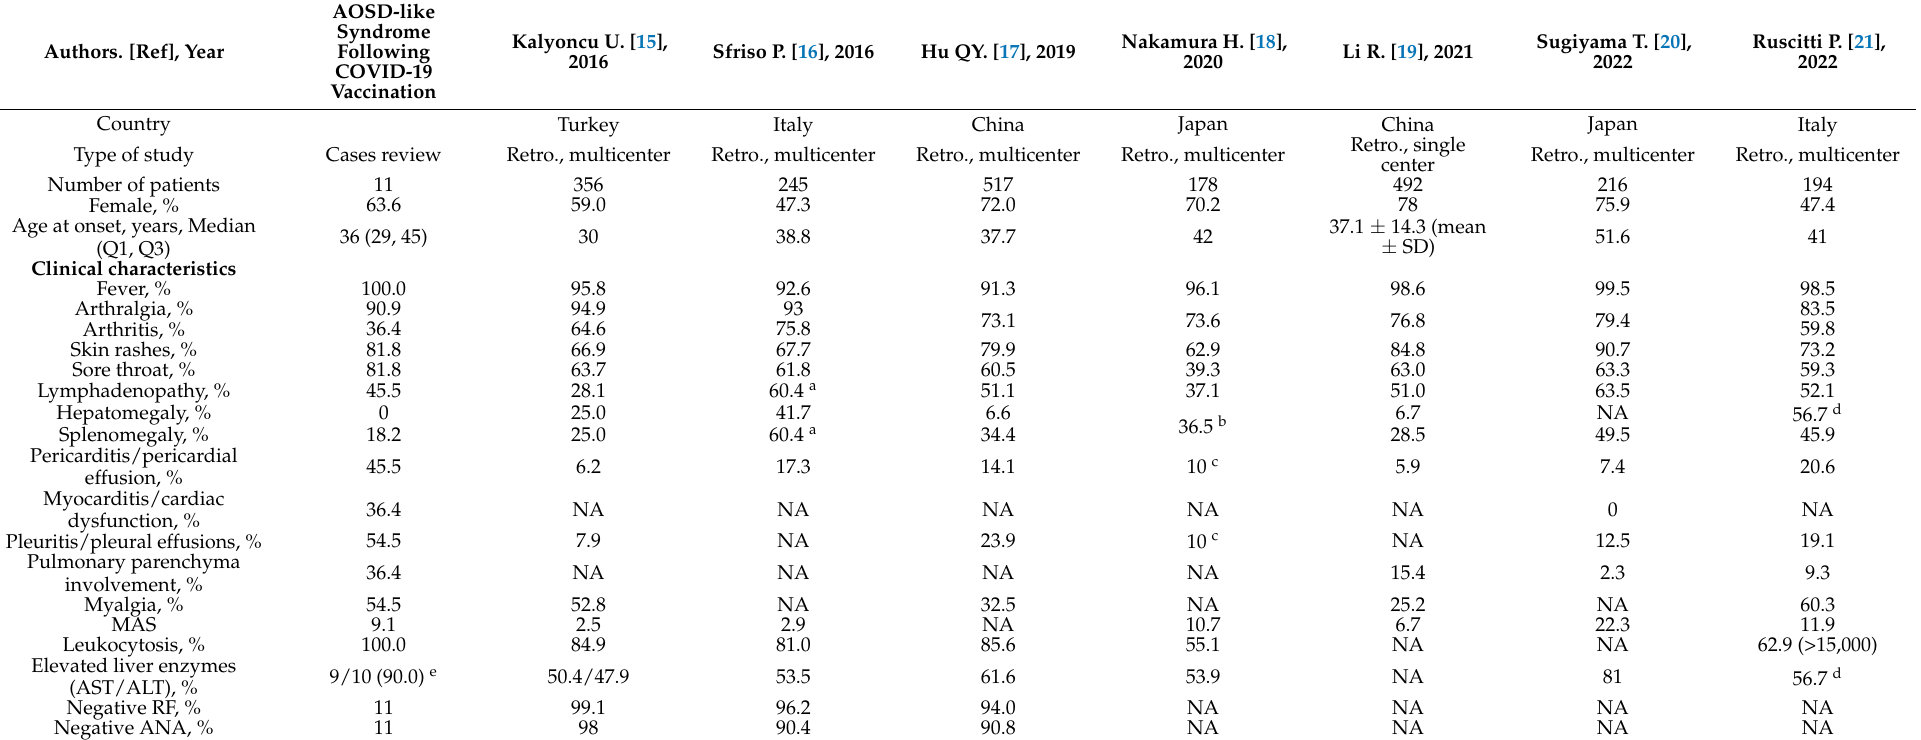
NA NA NA NA Retro. = retrospective study, MAS = macrophage activation syndrome, AST = aspartate aminotransferase, ALT = alanine aminotransferase, NA = not available, RF = rheumatoid factors, ANA = anti-nuclear antibodies. a = lymphadenopathy/splenomegaly, b = hepatosplenomegaly, c = serositis, d = liver involvement, e = 9 out of 10 for whom the data were